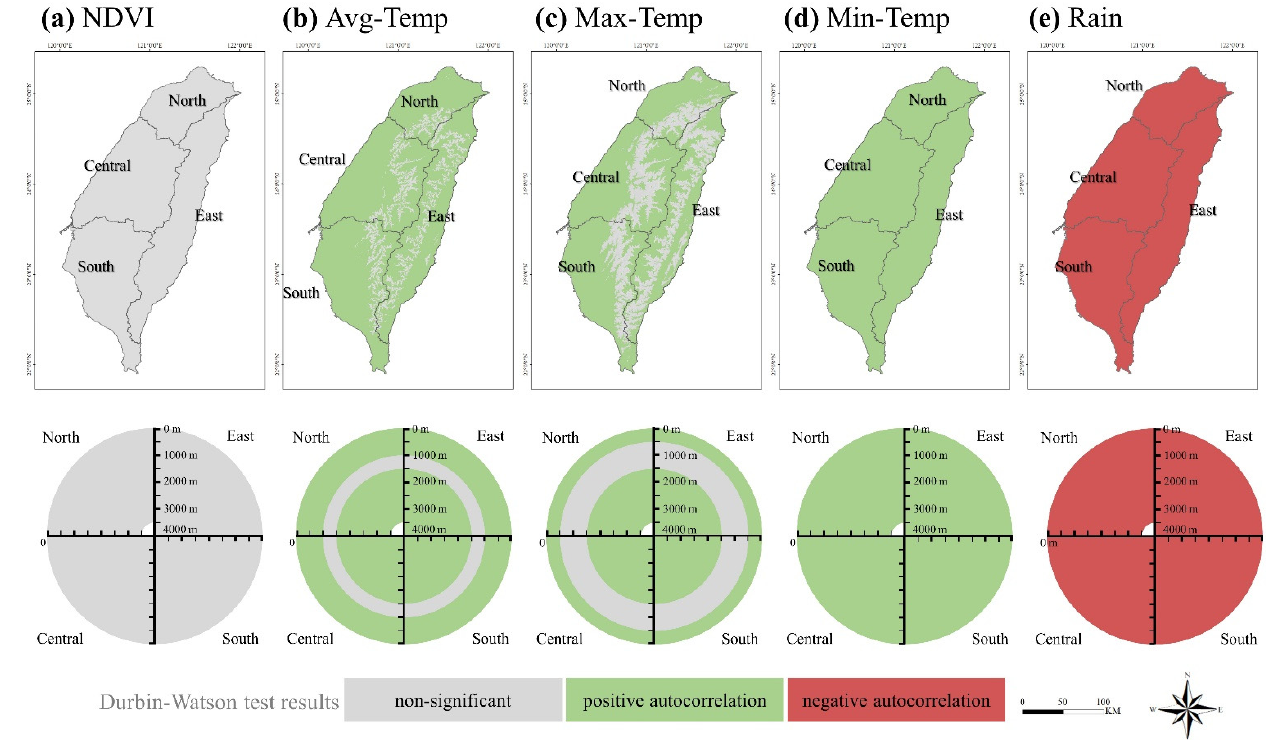
Figure 16. The outcome of the Durbin–Watson test for ( a ) NDVI and ( b – e ) climatic factors at varied elevations.